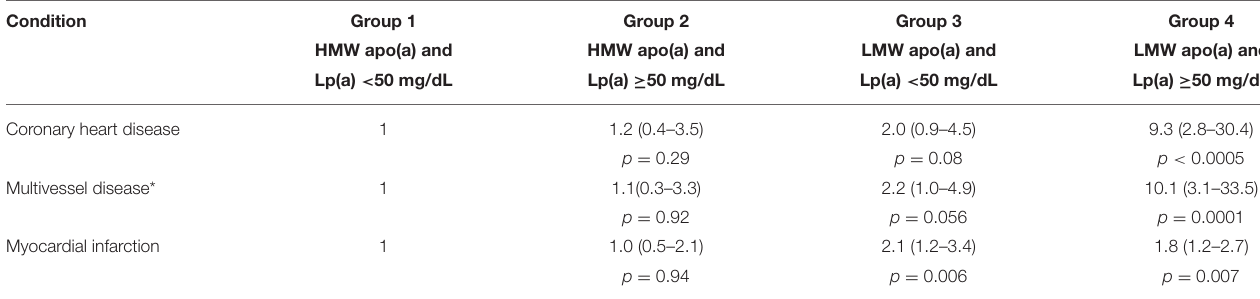
TABLE 3 | The odds ratios for coronary atherosclerosis and myocardial infarction depending on lipoprotein(a) levels and apolipoprotein(a) phenotype.